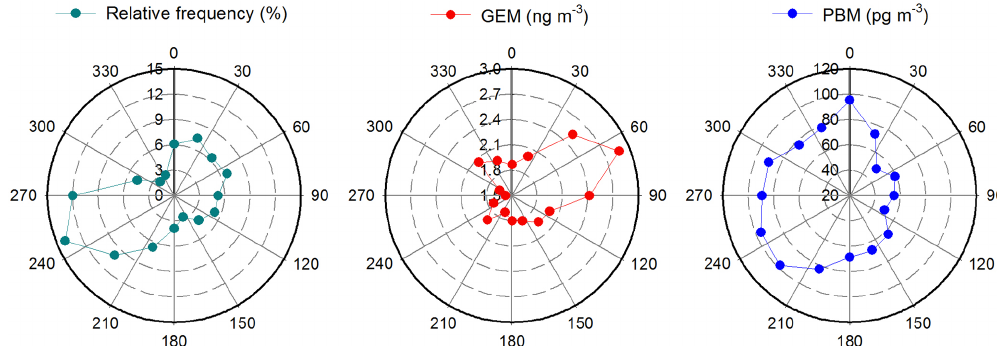
Figure 4. Frequency distribution of wind direction and wind-sector-based mean GEM and PBM concentrations during the study